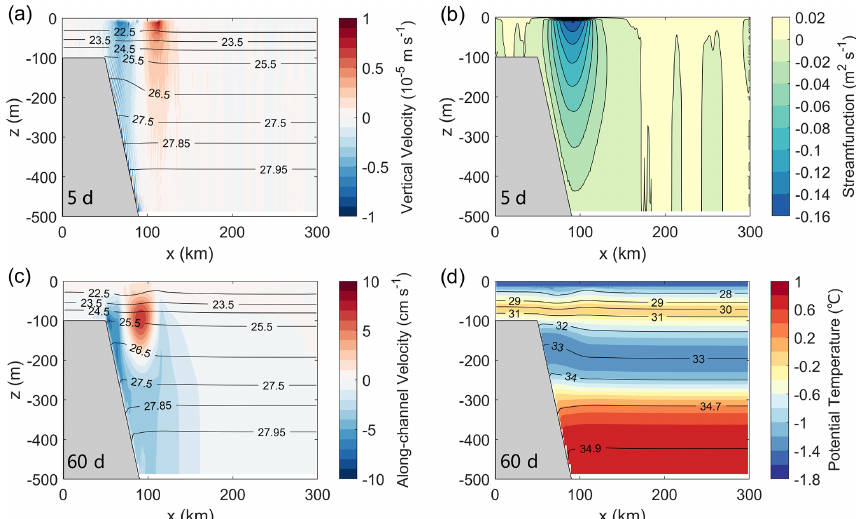
Figure 7. (a) Vertical velocity (color) overlain by isopycnals (black contours) and (b) overturning streamfunction averaged between y = 0 and 200km at t = 5d. (c) Along-channel velocity (color) overlain by isopycnals (black contours) and (d) potential temperature (color) overlain by isohalines (black contours) averaged between y = 0 and 200km at t = 60d. Table 1. The setup for the base and sensitivity experiments. Experiment Initial perturbation Ice–ocean drag Forcing Period (d)